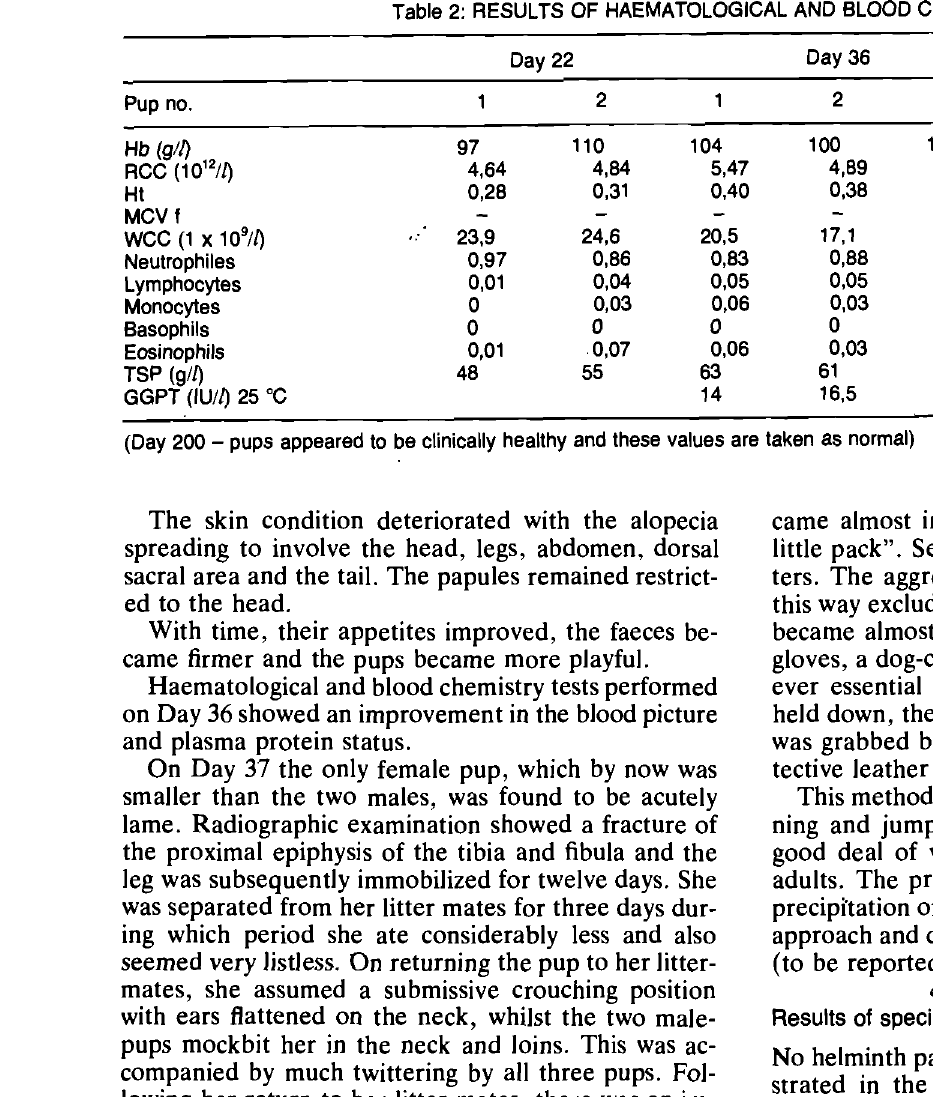
Table 2: RESULTS OF HAEMATOLOGICAL AND BLOOD CHEMISTRY TESTS Day